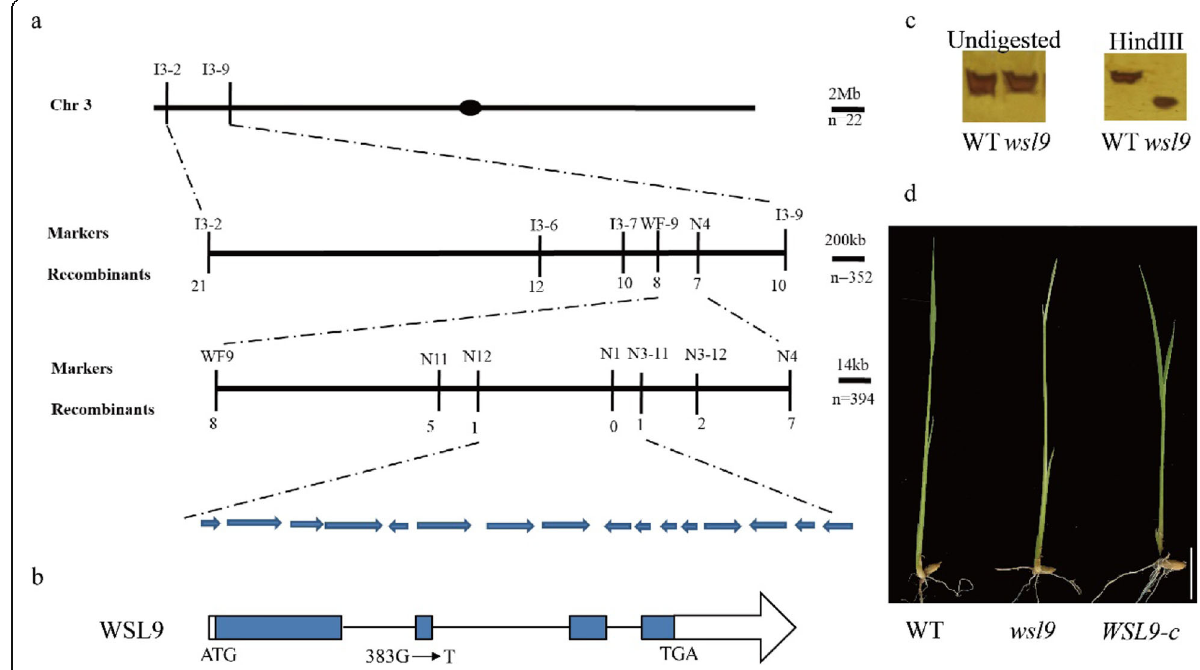
Fig. 4 Map-based cloning of the WSL9 locus and identification of the mutation site in wsl9 mutant . a WSL9 was mapped to a 89 kb region flanked by N12 and N3 – 11 in chromosome 3; 16 open reading frames (ORFs) were predicted in the mapped region. b Structural model of the WSL9 gene. ATG and TGA represent the start and stop codons, respectively. Blue boxes indicate exons, lines between boxes indicate introns, and white boxes indicate the 5 ′ - and 3 ′ -UTR. One of the single nucleotide changes resulted in a missense mutation. c Verification of the difference between wild-type and wsl9 genomic DNAs using dCAPs markers. d Complementation of wsl9 by transformation. Scale bar, 2 cm